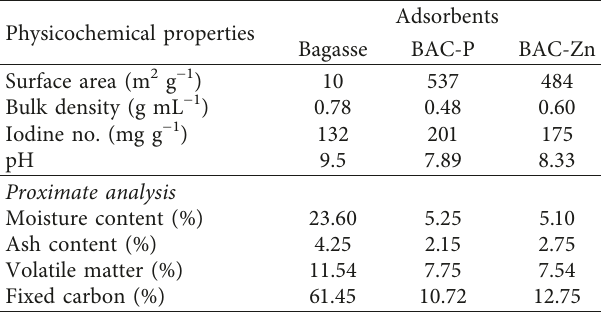
Table 1: Proximate analysis and physicochemical properties of the